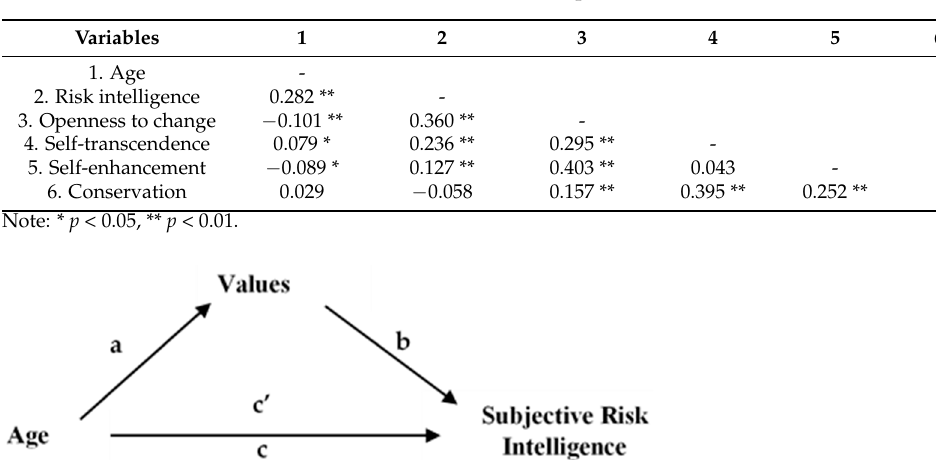
Table 2. Bivariate correlations between model variables (Spearman’s rho).